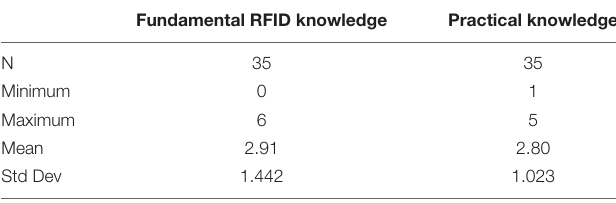
TABLE 2 | Baseline measurements for learning performance.